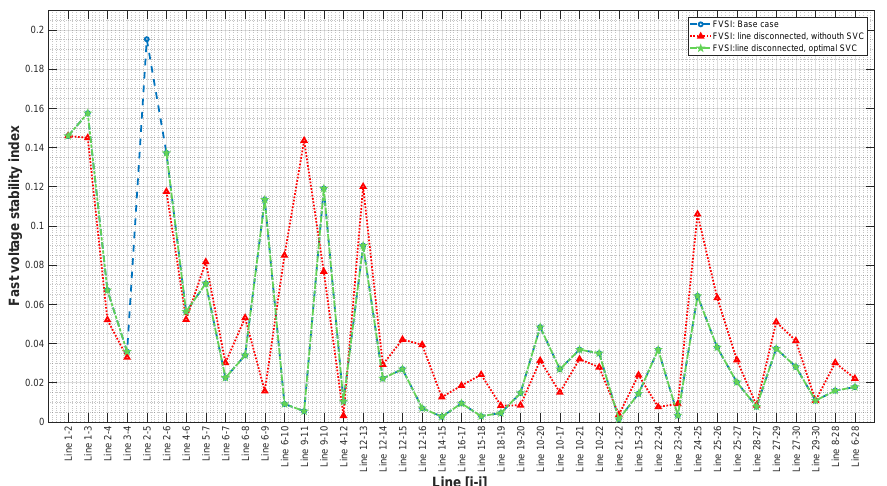
Figure 13. Second study case: FVSIs before/after contingencies and with SVC compensation, when the weakest line is disconnected.